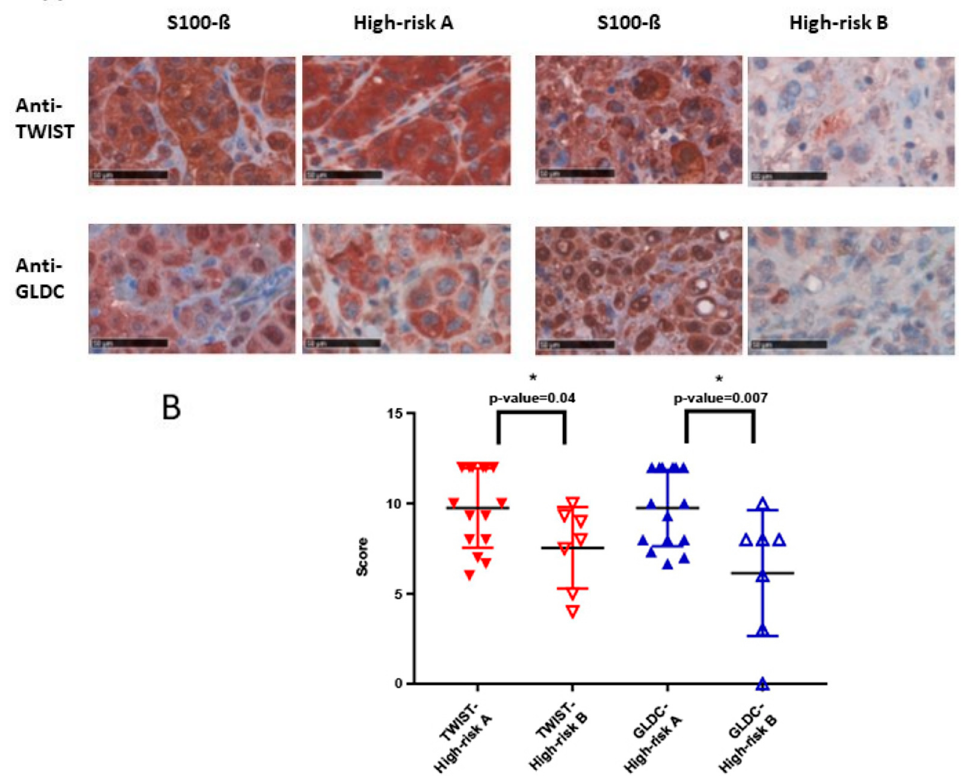
Figure 3. TWIST and GLDC high protein expressions are associated with metastasis development in high-risk primary melanomas. ( A ) Immunohistochemical stainings of high-risk primary melanomas are shown for TWIST and GLDC in high-risk group A and high-risk group B. Scale bar: 50 µm ( B ) Overall IHC score analyses of the two subgroups (high-risk group A and high-risk group B) are displayed in this chart. Y-axis shows the overall IHC score (0–12), which was calculated from the means of the products of quantity and intensity of the stainings. The displayed antibodies showed p -values < 0.05 (*) analyzed with two-tailed t -test.